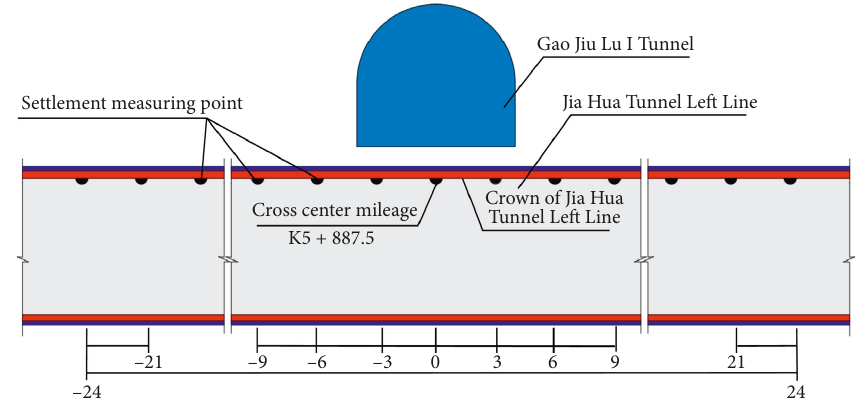
Figure 8: Arrangement of settlement survey points on the Jia Hua Tunnel Left Line crown (unit: m).